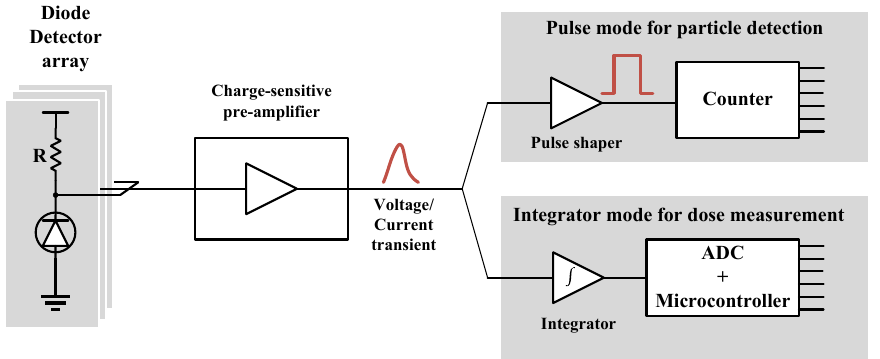
Figure 3. Illustrations of different methods (pulse mode and integral mode) of radiation detection of the Si-diode based radiation